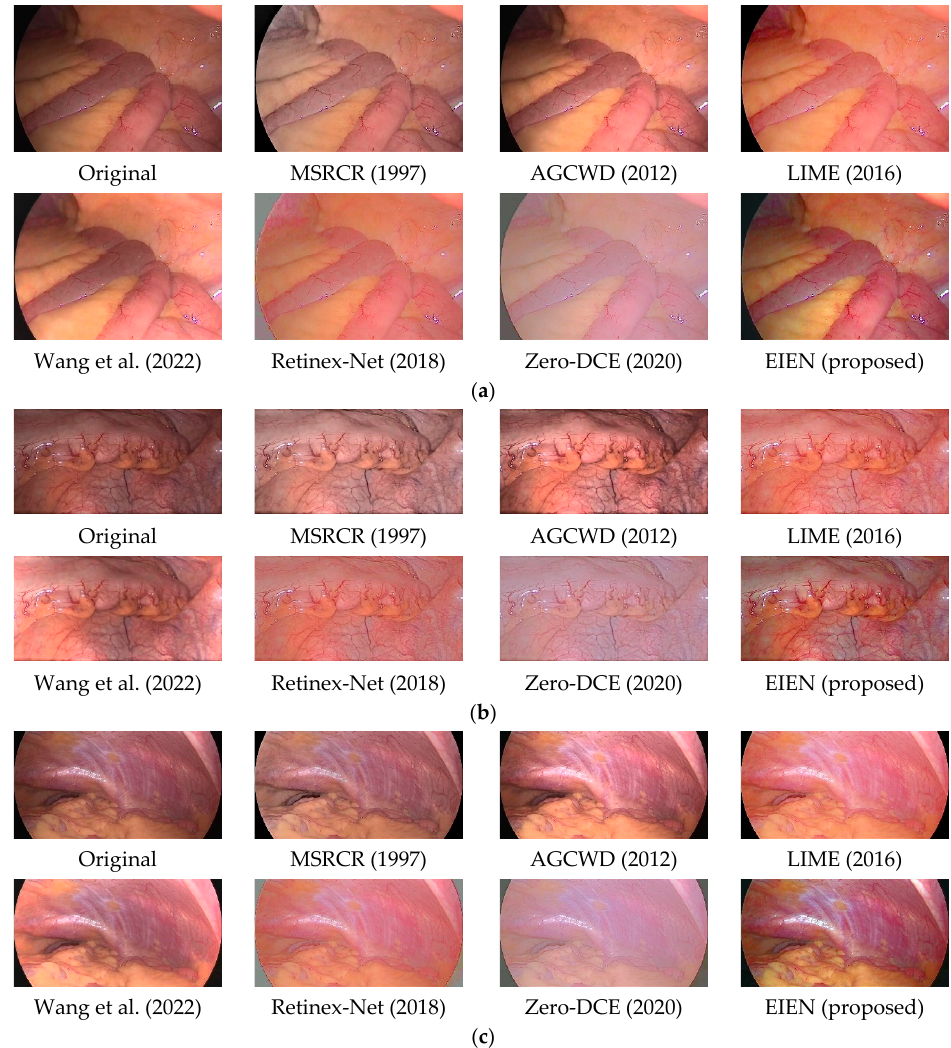
Figure 8. Comparison image of different methods. The three sets of images ( a – c ) include photos of different parts of the human body. The classical image enhancement methods and the enhancement results of the method proposed in this paper are shown